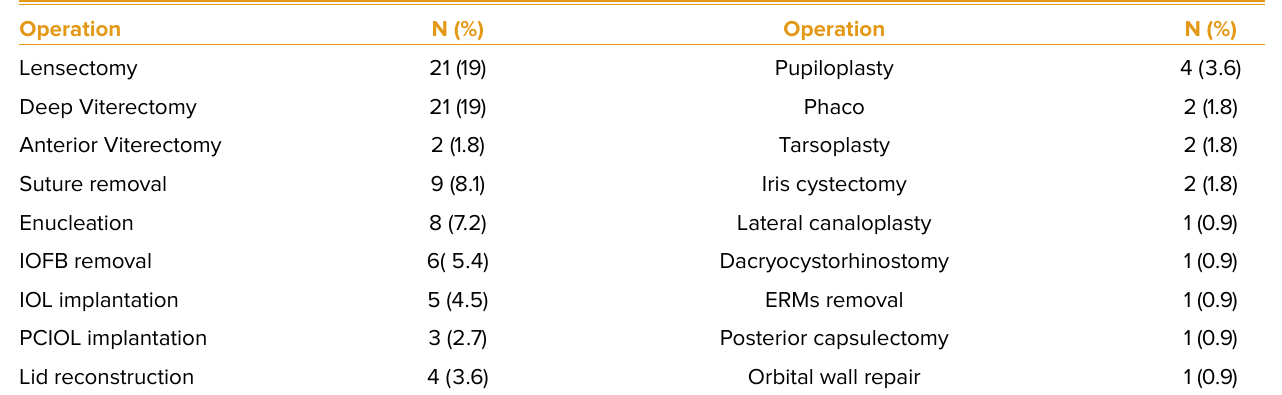
Table 6. Operations after the initial